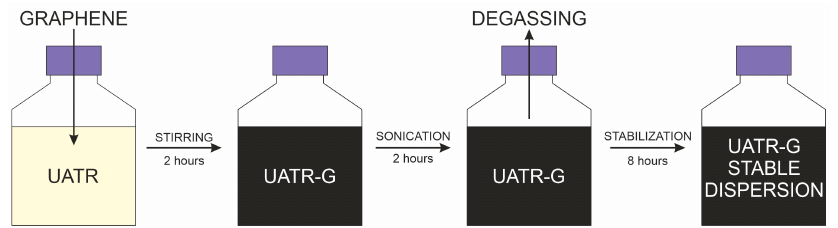
Figure2. Figure 2. Schematic representation of the preparation procedure for graphene-doped UATR (UATR-G) matrices.